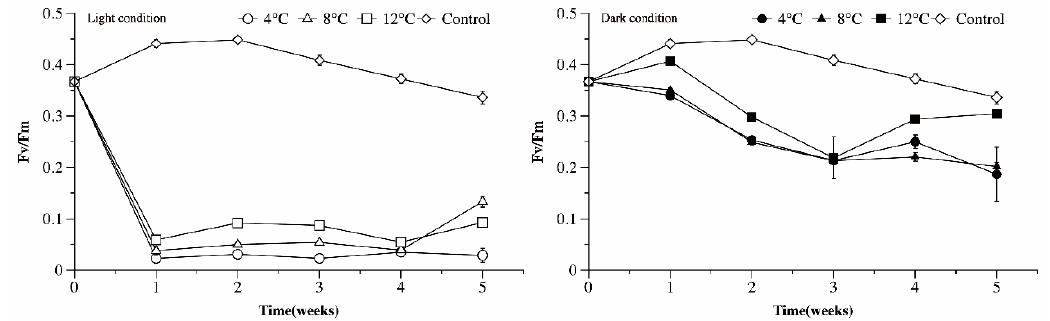
Figure 7. Side scatter, analyzed by FCM, of Ma cells exposed to different temperature and light conditions as a function of time.